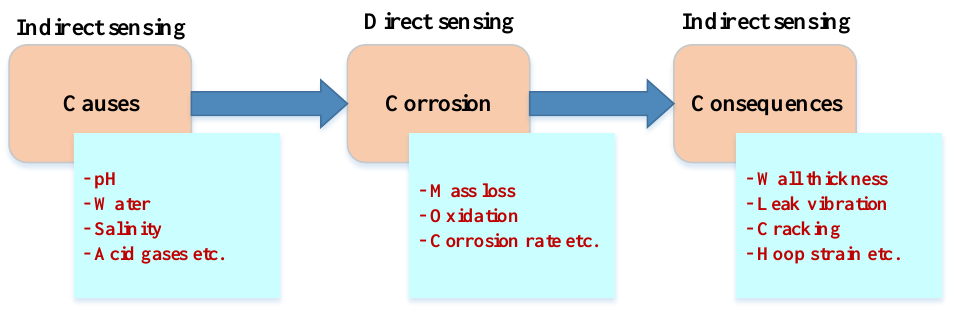
Figure 3. The ways of corrosion sensing to assess corrosion process from causes to consequences [33]. Table 2. A summary of different corrosion sensors and their